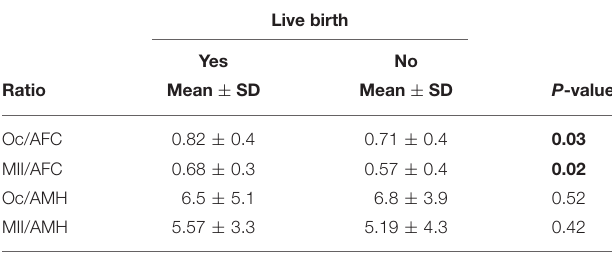
TABLE 1 | Oocyte yield indices in infertile women with or without live birth after the first embryo transfer. Live